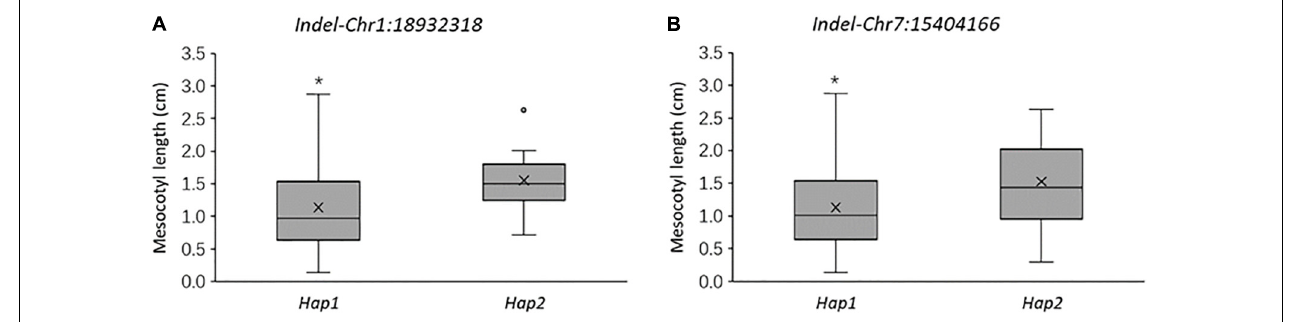
FIGURE 9 | Mesocotyl length comparison of two haplotypes at 18,932,318 bp on chromosome 1 (A) and at 15,404,166 bp on chromosome 7 (B) in 140 accessions from the XI-1B population. * P < 0.05 (significant differences between the alleles). TABLE 6 | ANOVA for mesocotyl length in the XI-1B panel by two markers. Marker df Sum of squares Mean square F -value Pr( > F